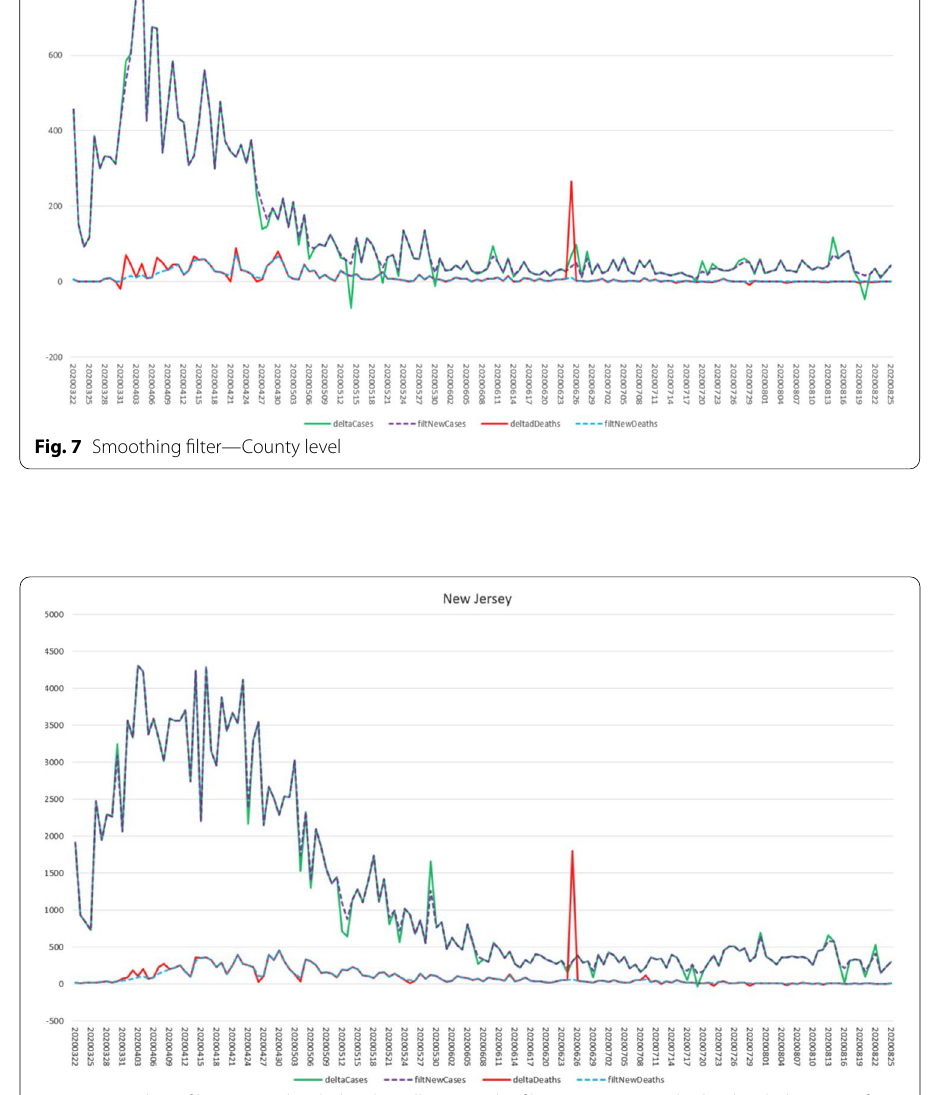
the equivalent for Deaths. “filtNewCases” and “filtNewDeaths” are the adjusted versions of the delta time series based on the Smoothing Filter. Note that the anachronous spike in deaths (red line), and the negative spikes in delta cases (green line) have been effectively removed from the filtered series. Also note that toward the end of the green line several anomalous spikes have also been attenuated.